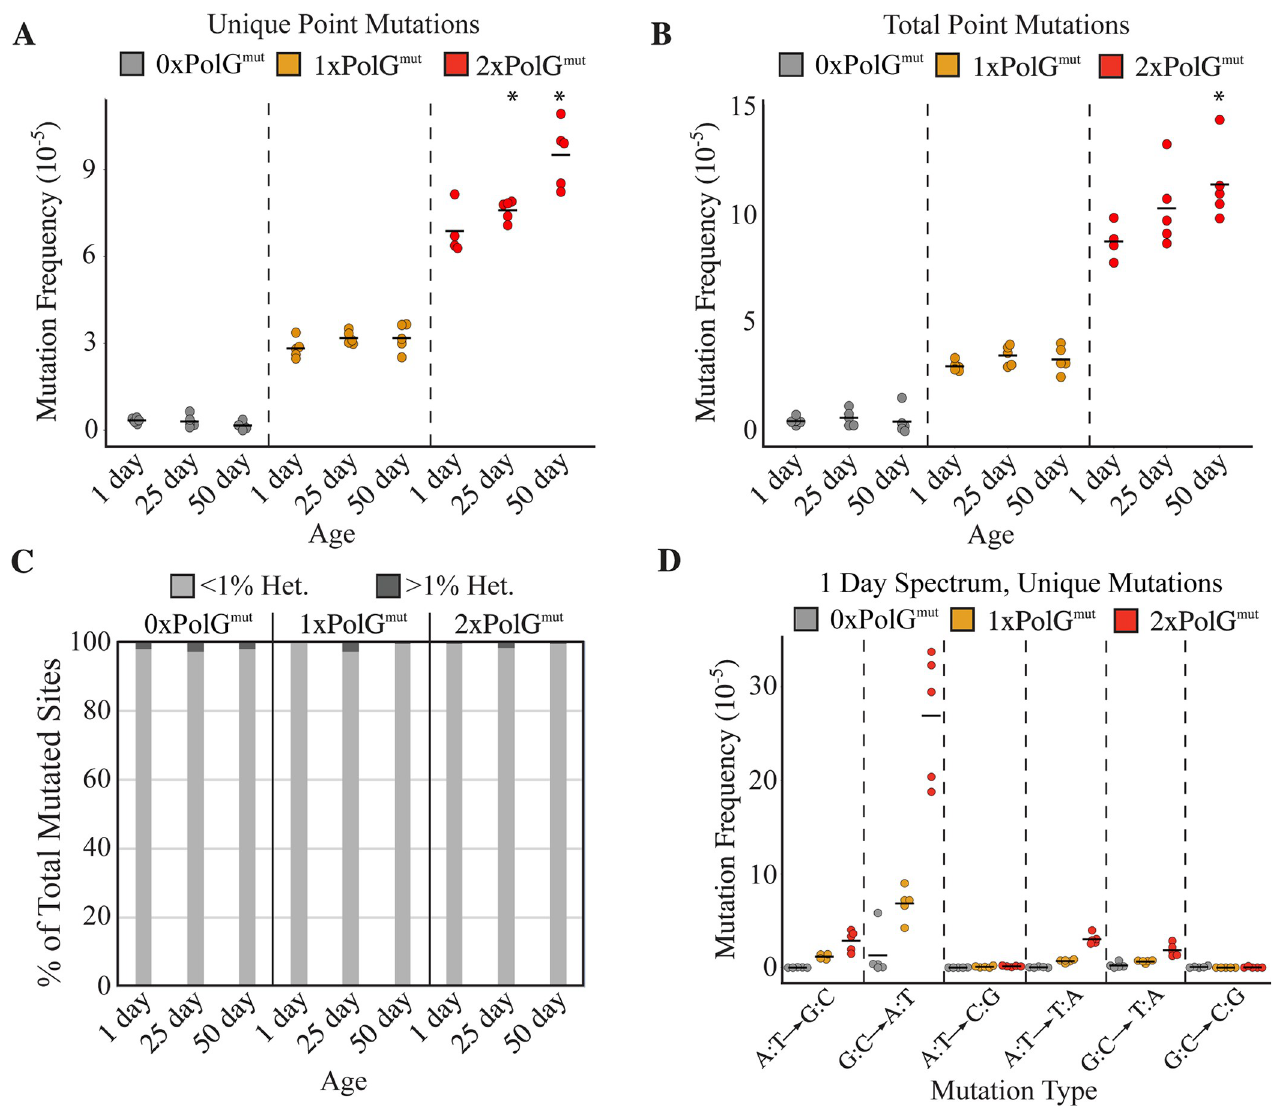
Fig 2. Transgenic expression of an exonuclease-deficient PolG results in a dose-dependent increase in mutation frequency. The frequencies of base substitution mutations were quantified in 1-day-old, 25-day-old, and 50-day-old flies of the given genotype using DS. (A) The mutation load of unique mutations, representing each unique mutation counted once, thus reflecting the de novo somatic mutation frequency. (B) The frequency of total mutations. (C) The percentage of mutated sites at sub-clonal levels ( < 1% heteroplasmy) and clonally expanded mutations ( � 1% heteroplasmy) in flies of the indicated age and genotype. (D) The frequency of unique mutations of each type of base substitution mutation is indicated in 1-day-old flies of the indicated genotypes. N = 5 per genotype per time point. Horizontal bars in panels A, B, and D represent the mean frequency of the indicated group. � p < 0.05 compared to 1-day-old flies of the same genotype by Wilcoxon rank-sum test. 1x and 2xPolG mut flies displayed significantly elevated mutation frequencies compared to age-matched control 0xPolG mut flies at all time points (p < 0.05 by Wilcoxon rank-sum